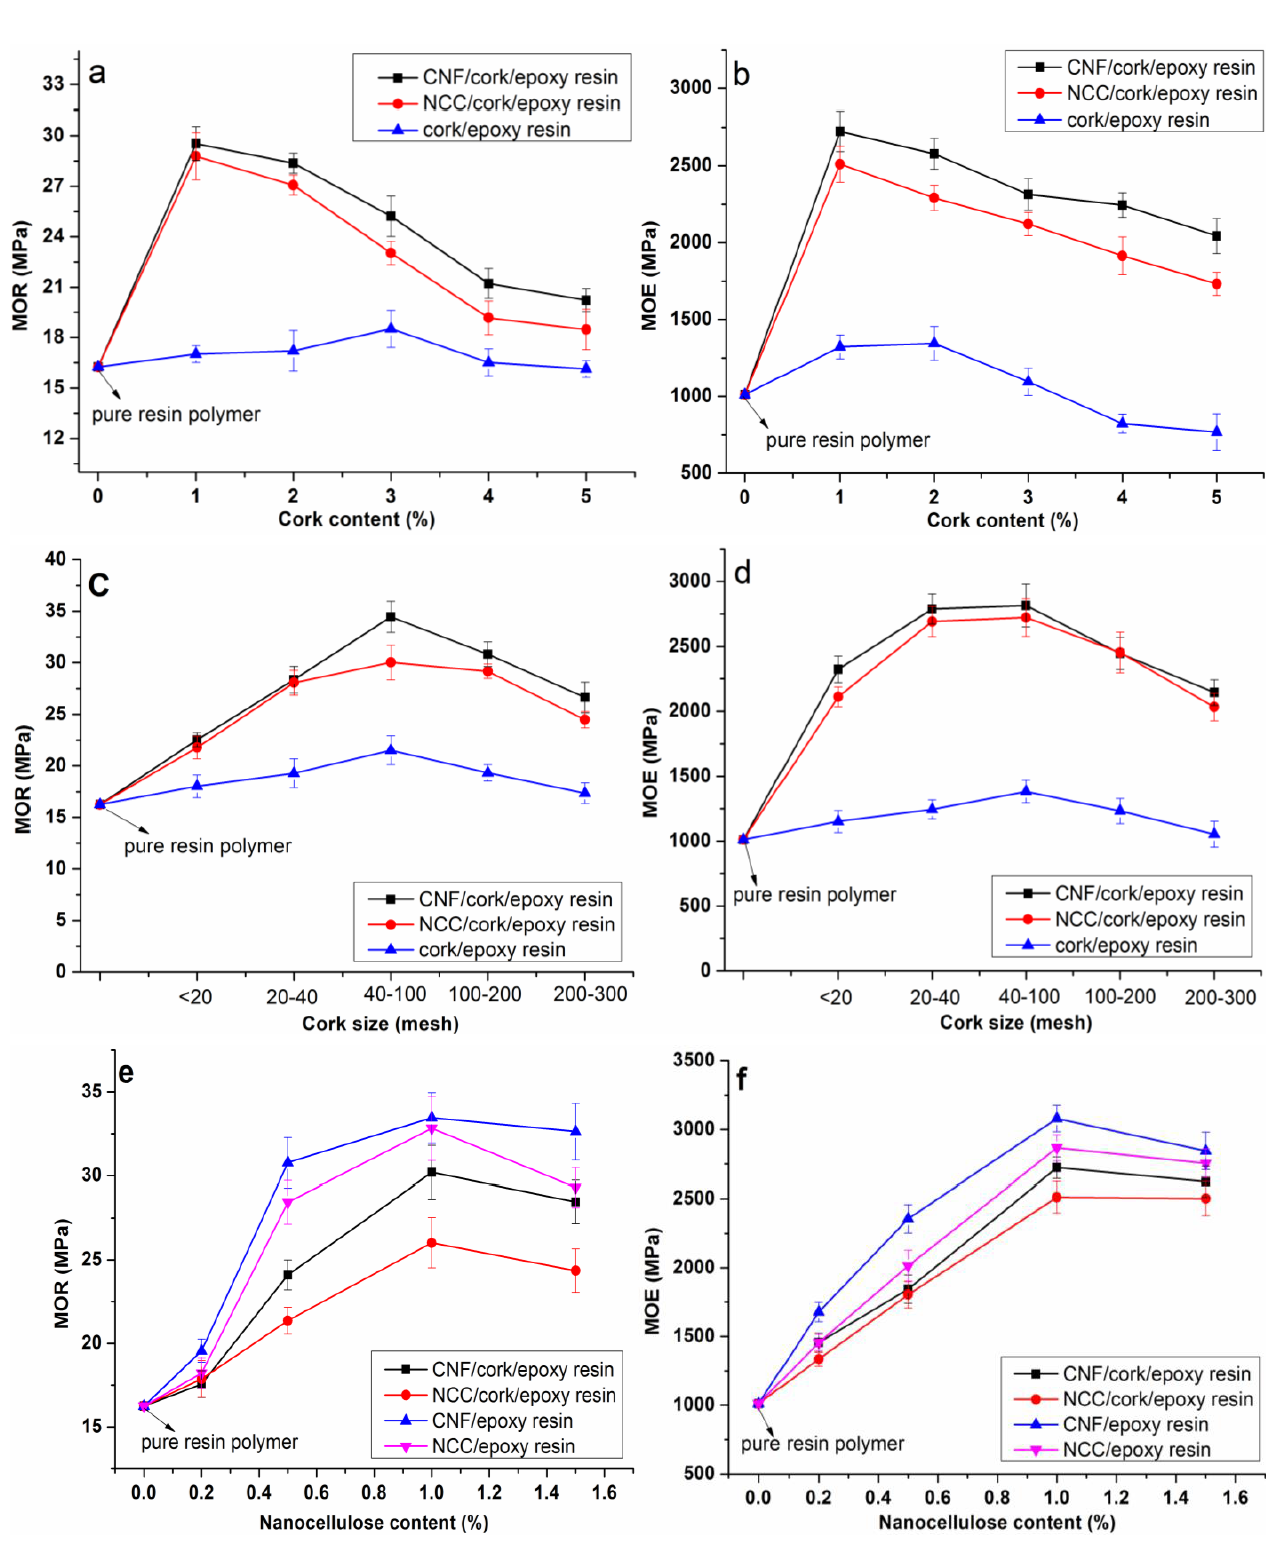
Figure 4. The flexural strength and modulus of the rosin − based composites, ( a , b ) MOR and MOE of composites with different cork contents, ( c , d ) MOR and MOE of composites with different cork sizes, ( e , f ) MOR and MOE of composites with different nanocellulose contents.